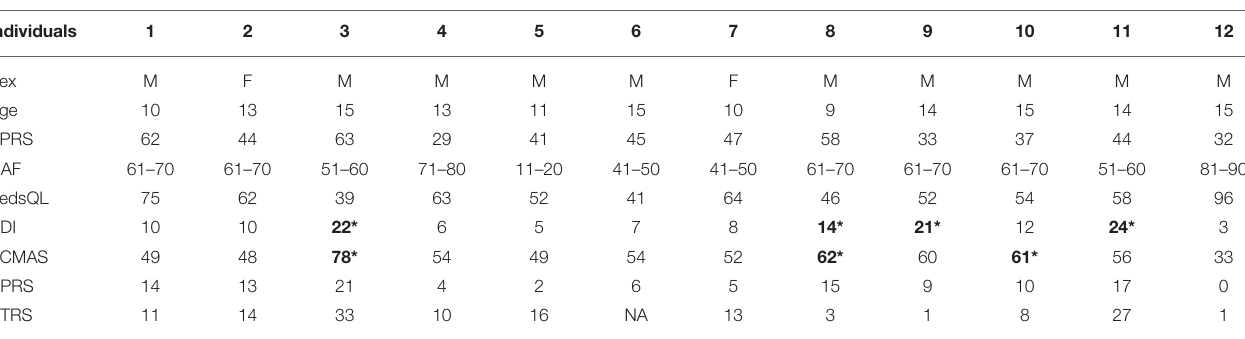
TABLE 5 | Characteristics and results of the psychiatric rating scales for each child and adolescent included in the study ( n = 12). Individuals